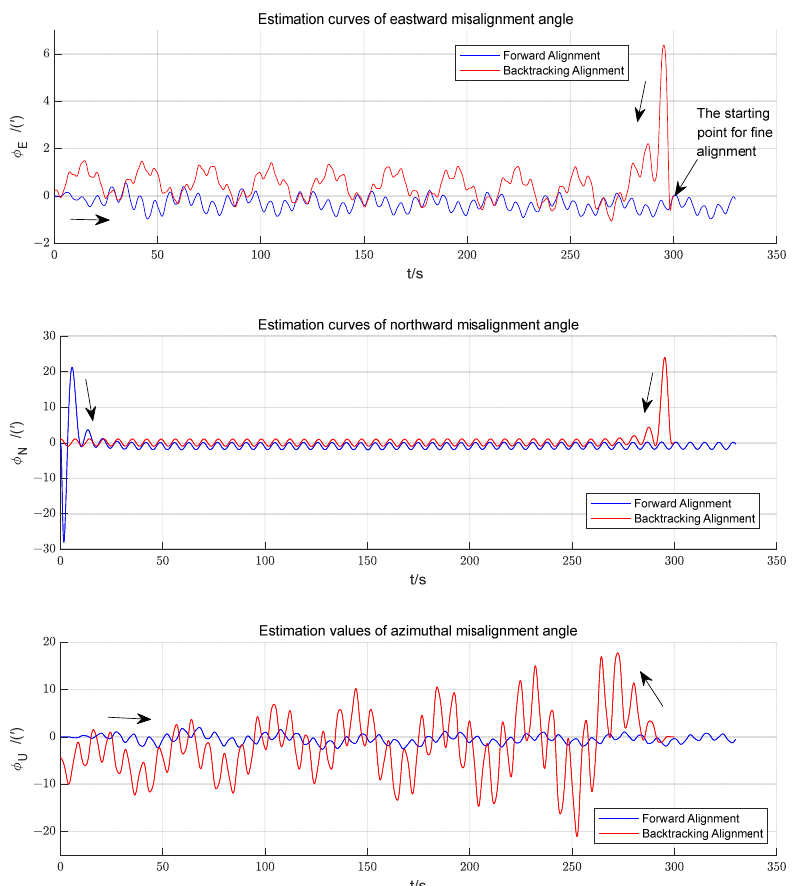
Figure 6. Estimated curves of the misalignment angles during the first backtracking navigation FA and the first forward navigation FA. and the first forward navigation